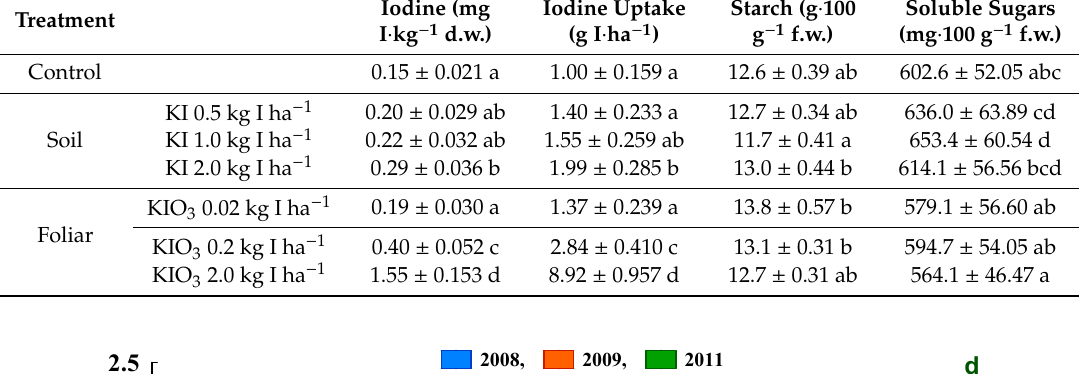
Figure 2. Iodine content in potato tubers in individual years the study; values followed by the same letters within an individual year are not statistically different at p < 0.05, ( n = 4).